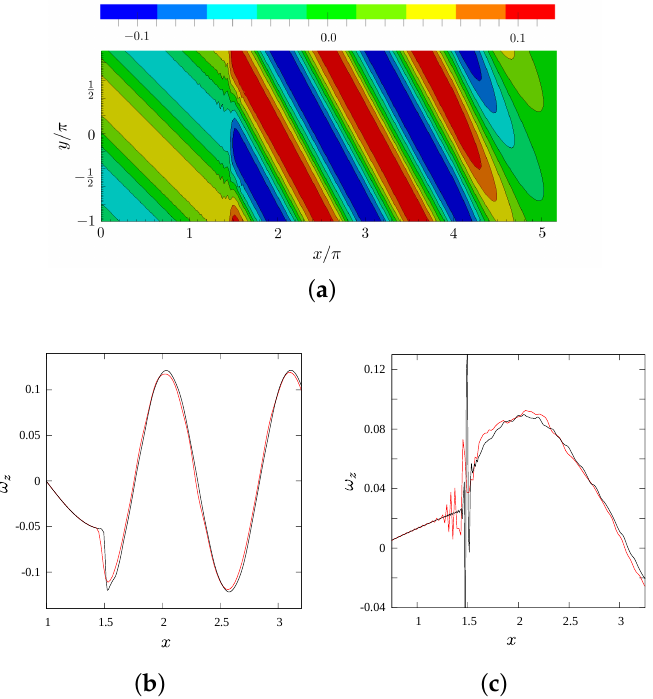
Figure 7. Shock-vorticity/entropy wave interaction. ∆ y = π /32; Red curve: ∆ x = π /50; black curve (finer grid): ∆ x = π /100. ( a ) Vorticity ω z contours at t = 25 for ψ = 45 ◦ , k y = 1; ( b ) ω z along y = 0 for ψ = 45 ◦ , k y = 1 at t = 25; and ( c ) ω z along y = 0 for ψ = 75 ◦ , k y = 1 at t =